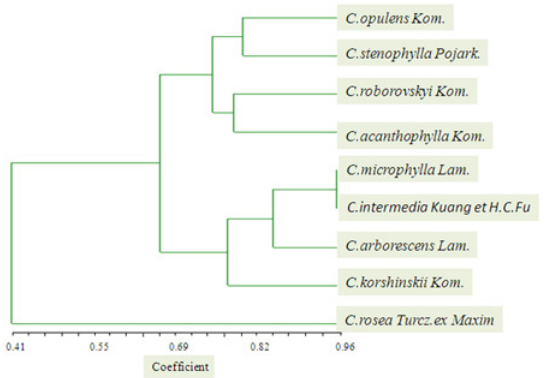
Fig 4. Graph of genetic distance among the UPGMA dendrogram of the genetic relationships among 9 species from Caragana Fabr genus. The dendrogram was generated using the Jaccard similarity coefficient based on 118 polymorphic primer